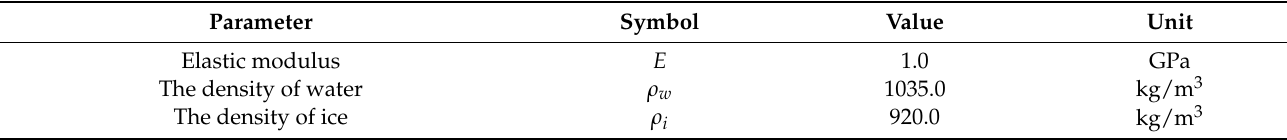
Table 4. Main parameters of sea ice discrete element calculation.